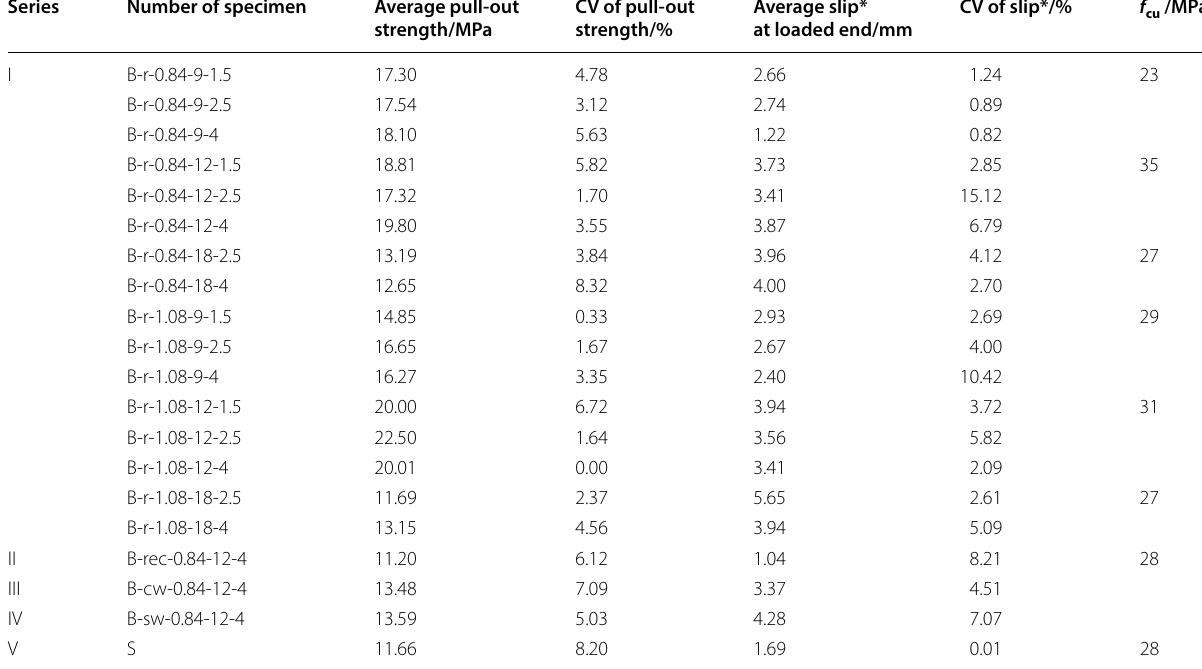
Table 4 Results of pull-out test under mono-tensile load.